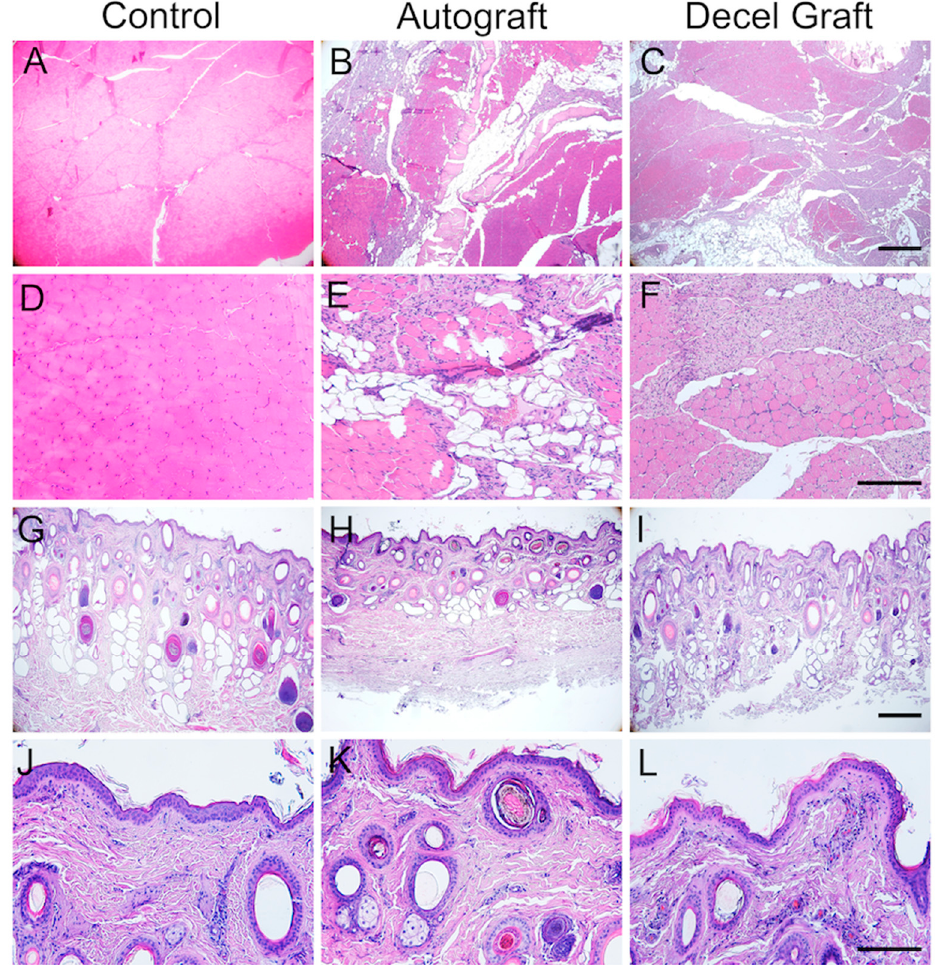
Figure 8. Representative micrographs of cross sections of the Tibialis Anterior muscle stained with hematoxylin and eosin from ( A , D ) the contralateral side (control), ( B , E ) an animal from AG group, ( C , F ) an animal from DC group. A , B, C scale bar 200 µ m, and D , E , F scale bar 100 µ m. Representative micrographs of perpendicular sections of the skin of the dorsum of the foot stained with hematoxylin and eosin from ( G , J ) the contralateral side (control), ( H , K ) an animal from AG group, ( I , L ) an animal from DC group. G , H , I scale bar 200 µ m, and J , K , L scale bar 100 µ